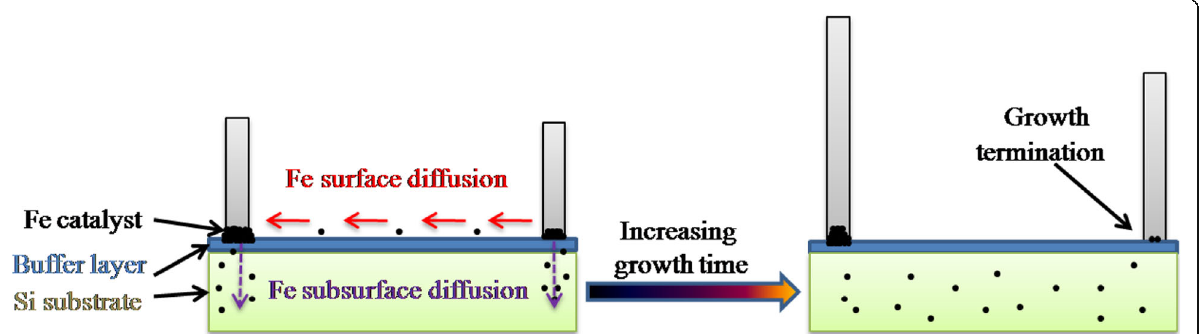
Fig. 3 Schematic illustration of Ostwald ripening and subsurface diffusion of Fe catalysts during the growth period of VACNTs